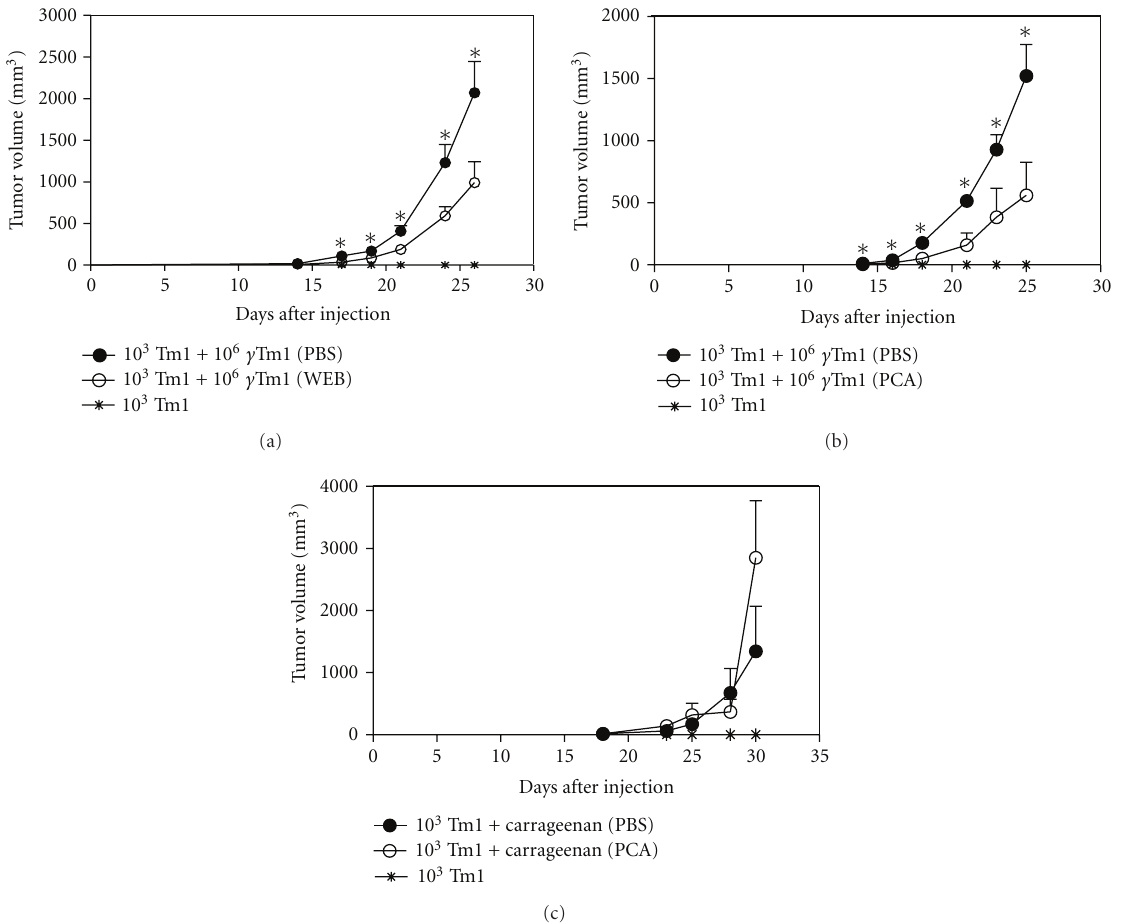
Figure 1: PAFR antagonists reduce melanoma growth associated with a massive number of apoptotic cells. The treatment of C57Bl/6 mice with PAFR antagonists showed a significant reduction in the melanoma growth (10 3 Tm1 viable cells) induced by apoptotic cells (10 6 γ - irradiated Tm1 cells, (a) and (b)) but not by carrageenan (0.1% (c)). The animals were treated with PBS or PAFR antagonists (WEB2170 (WEB, (a)) or PCA4248 (PCA, (b) and (c)) 5mg/kg body weight)) by peritumor daily injections during 5 days. All experiments were performed using groups of 5 to 10 mice, which were considered harboring tumors when the subcutaneous mass reached 20 mm 3 (palpable tumor). ∗ Denotes statistical significance ( P < 0 . 05) using nonpaired nonparametric Student’s t